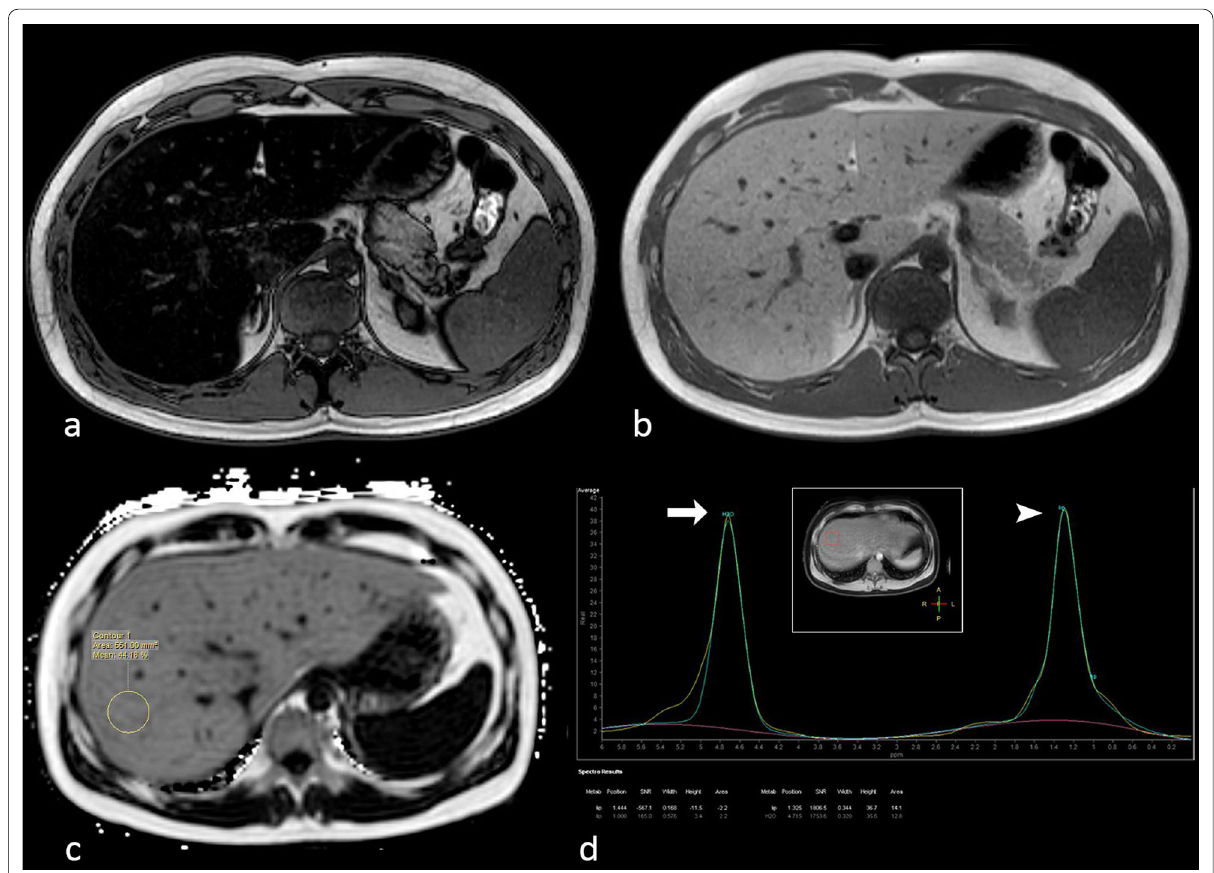
Fig. 2 Opposed-phase ( a ) and in-phase ( b ) gradient echo (GE) T1-w. images of the upper abdomen show severe hepatic steatosis. A proton density fat fraction (PDFF) sequence ( c ) demonstrates a fat fraction of 44% in liver segment VIII. Hydrogen-spectroscopy ( d ) confirms the fat